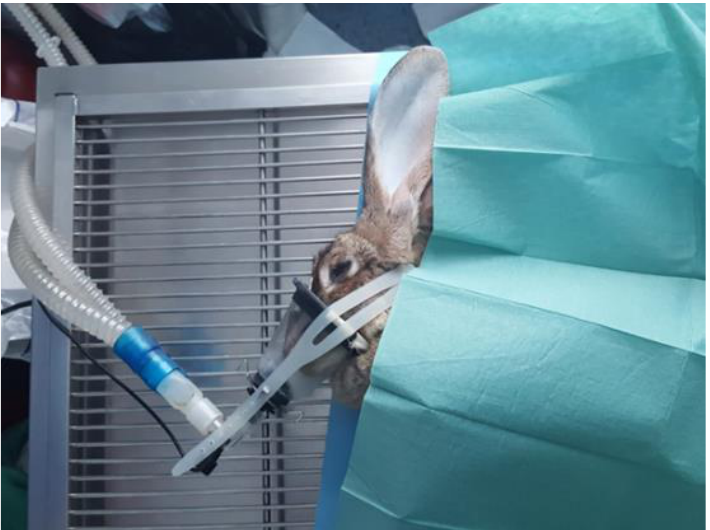
Figure 2. Aspect of a case under